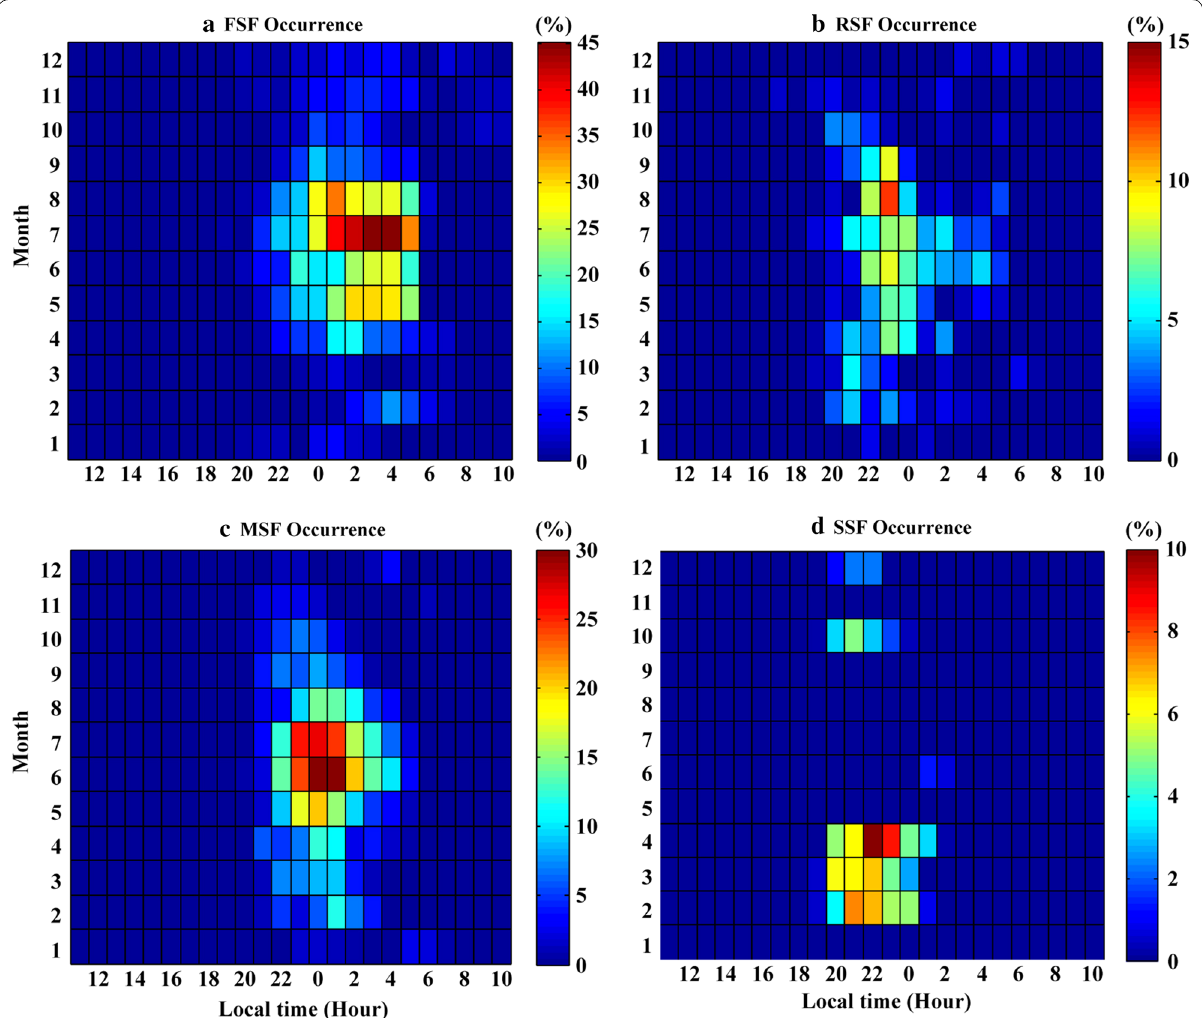
Fig. 3 SF occurrence rates for 2015 and 2016 as a function of local time (LT) and month. Colors represent the occurrence